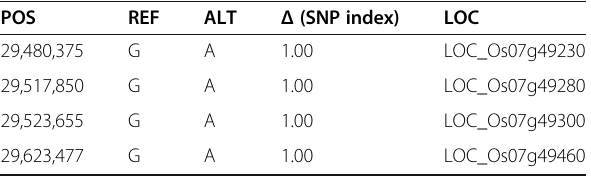
Table 1 Information of SNPs with Δ (SNP index) of